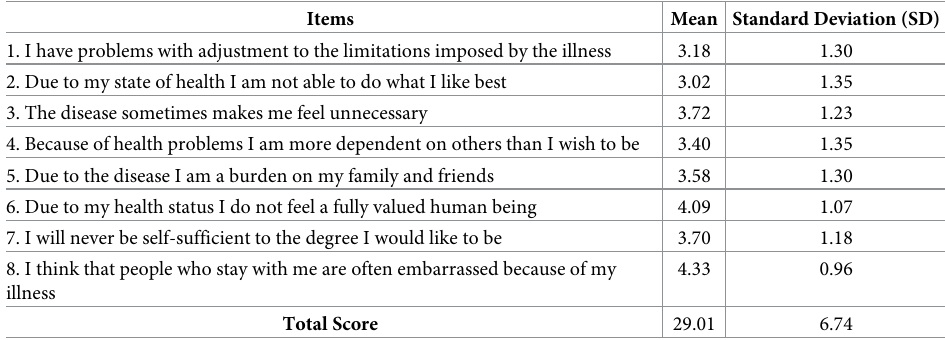
Table 3. Mean and standard deviations by item (n =